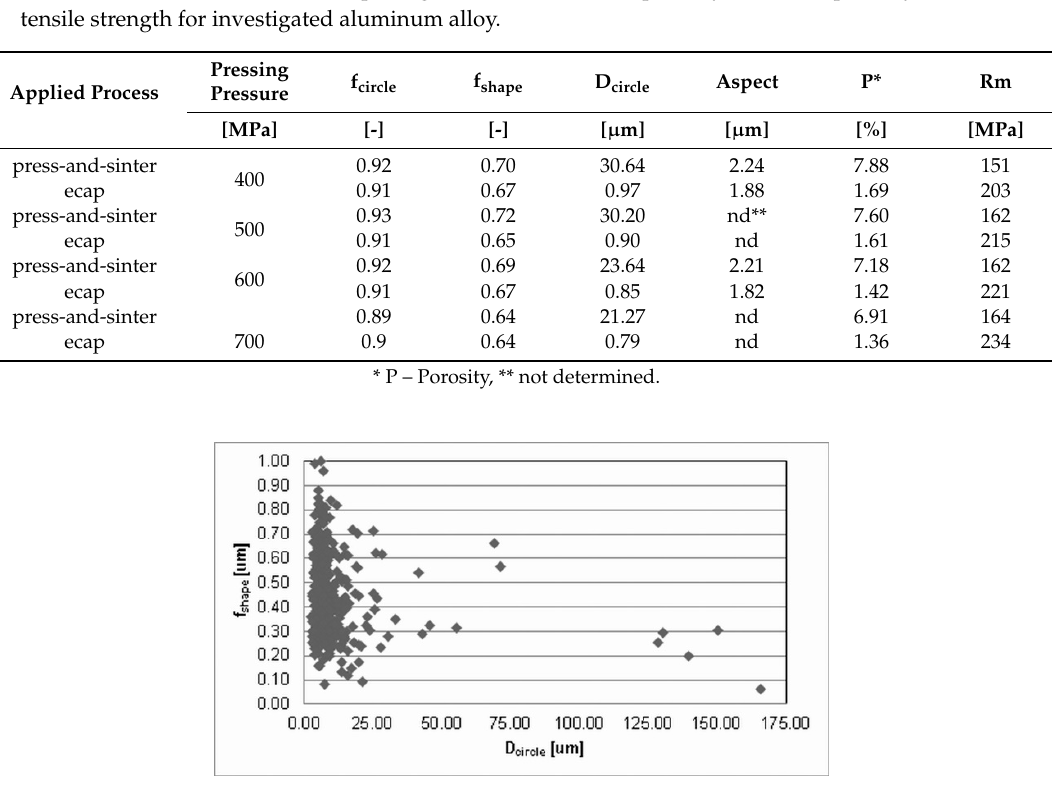
Figure 2. The dimensional and morphological characteristics, f shape , of porosity for press-and-sinter specimens (400 MPa).